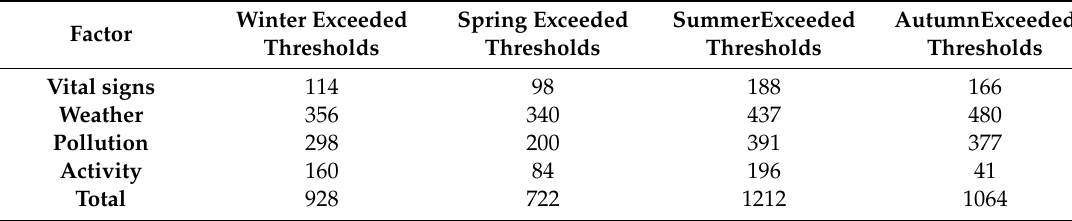
Table 12. Total number of alarms.